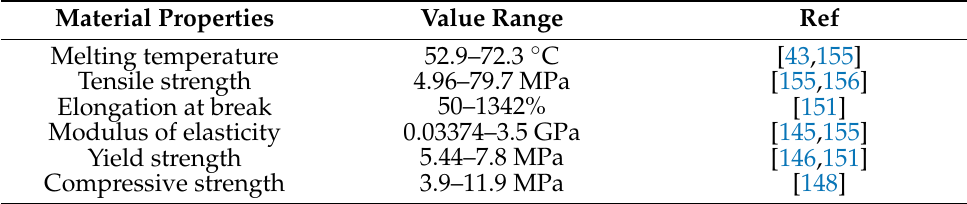
Table 6. Physical and mechanical properties of PCL and its composite material.